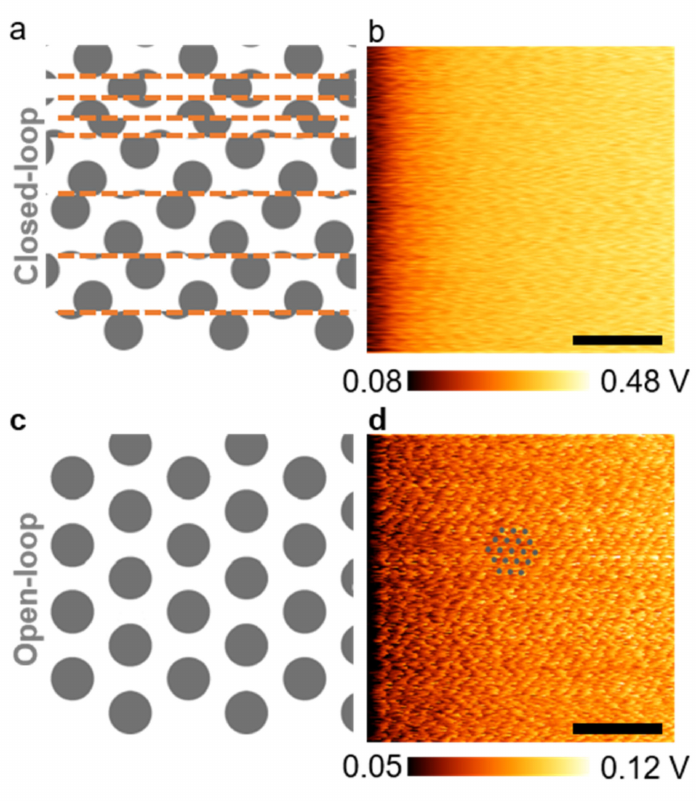
Figure 1. Lateral force microscopy (LFM) raw images obtained with or without engaging the XY closed-loop control in air (color range adjusted). ( a ) Schematic representation of a jumbled LFM image due to the use of a XY closed-loop control. The orange dashed lines indicate the locations at which the piezo stage was abruptly repositioned due to the XY closed-loop control; ( b ) LFM image of a MoS 2 monolayer obtained with a closed-loop control (calibrated scale bar: 2 nm; scan rate: 21 Hz); ( c ) schematic illustration of the LFM image of a two-dimensional (2D) lattice expected in the absence of the XY closed-loop control; ( d ) LFM image of a MoS 2 monolayer obtained without a closed-loop control, which revealed a periodic pattern from the atomic lattice (calibrated scale bar: 2 nm; scan rate: 21 Hz). The grey dots are a guide for the eye and correspond to the lattice of rate MoS 2